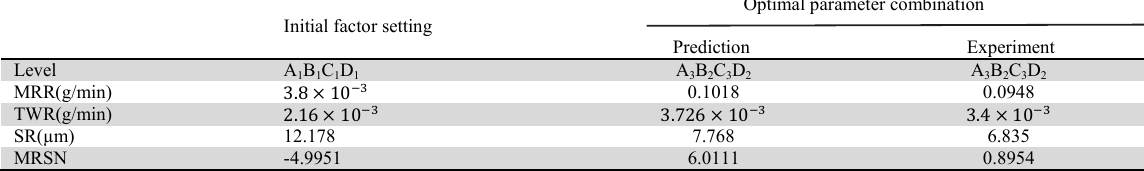
Results of the confirmatory experiment for MRSN ratio method